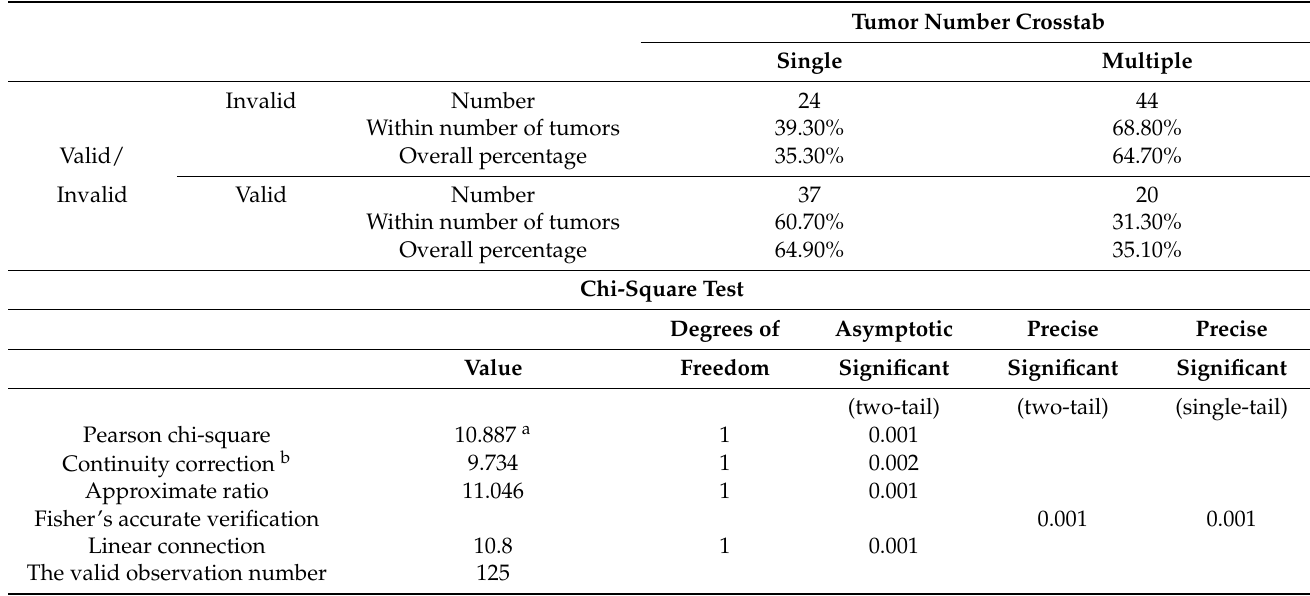
Table 5. Microsphere treatment (DC bead TACE), excluding mixed-sized and 500–700 µ m-sized